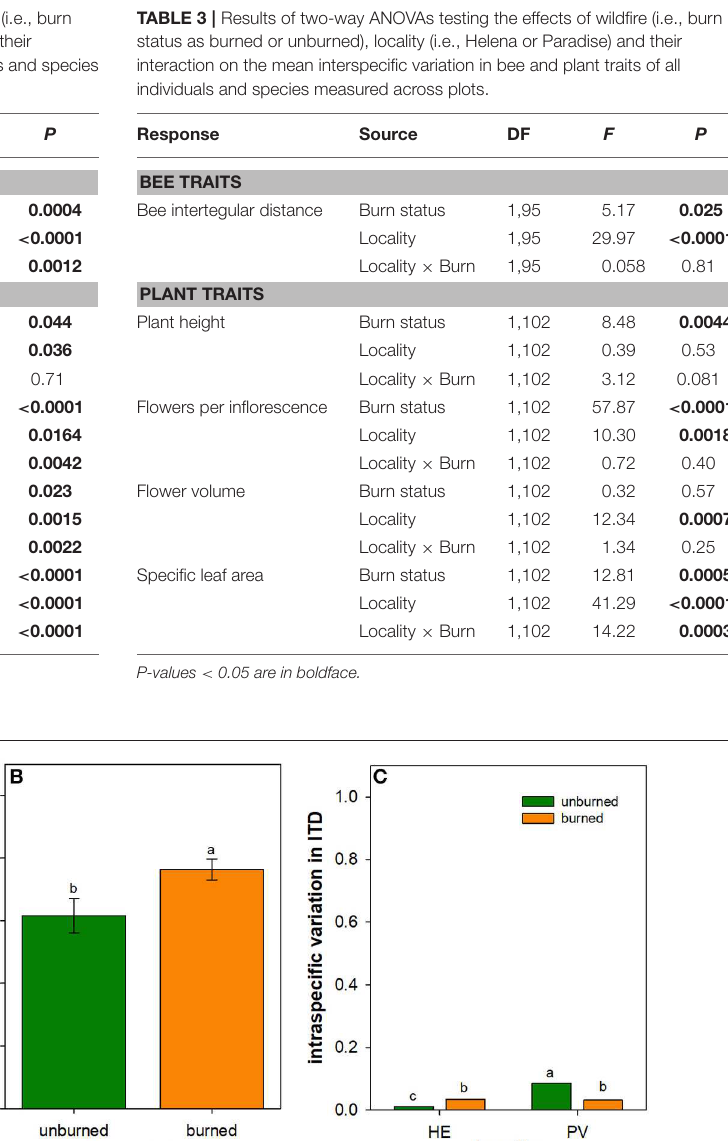
Frontiers in Ecology and Evolution |